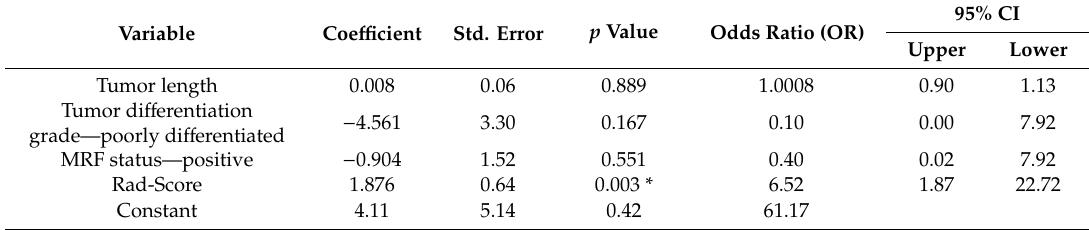
Table 5. Multivariate logistic regression analysis for the prediction of non-responders—complex